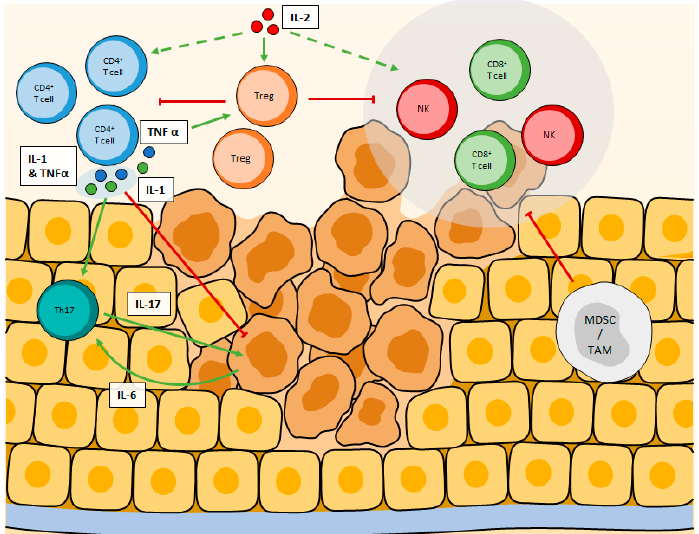
Figure 1. Ambivalent cytokines modulating CD4 + T cell responses in the tumor microenvironment. IL-2 stimulates both CD4 + , CD8 + , and NK cells but has a greater affinity for the IL2R αβγ expressed by Tregs. High doses of IL-2 enhance anti-tumor immune response while low doses preferentially stimulate Tregs proliferation, leading to immune suppression. Similarly, while high doses of TNF α and IL-1 have anti-tumor effects, in the lower amount, they both stimulate Th17 cells, plus Tregs for TNF α , leading to angiogenesis and immunosuppression, which favor tumor